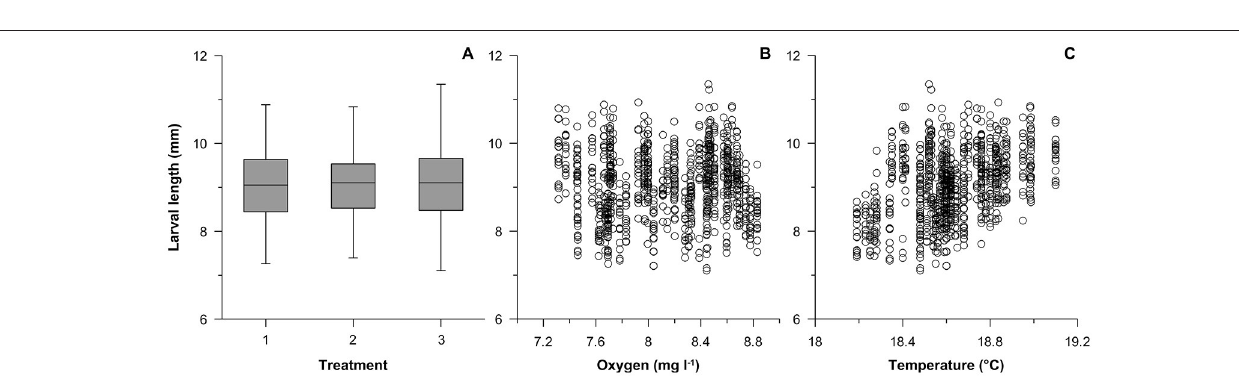
FIGURE 3 | Relation between the final larval length (at day 21) of Gasterosteus aculeatu s and treatment ( A ; 1: ambient, 2: intermediate pH and 3: low pH), oxygen concentration (B) or temperature (C)